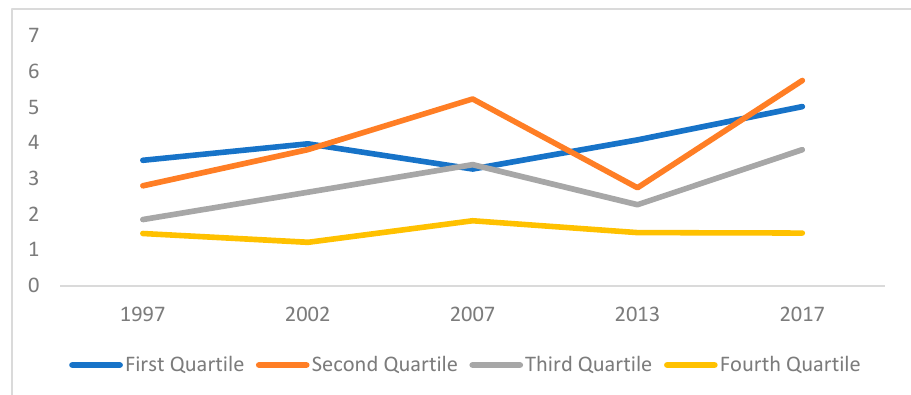
Figure 7. Diagrammatical illustration of the trend of Income Elasticity of OOPHE. Pseudo-panel methods are an alternative to using panel data for estimating